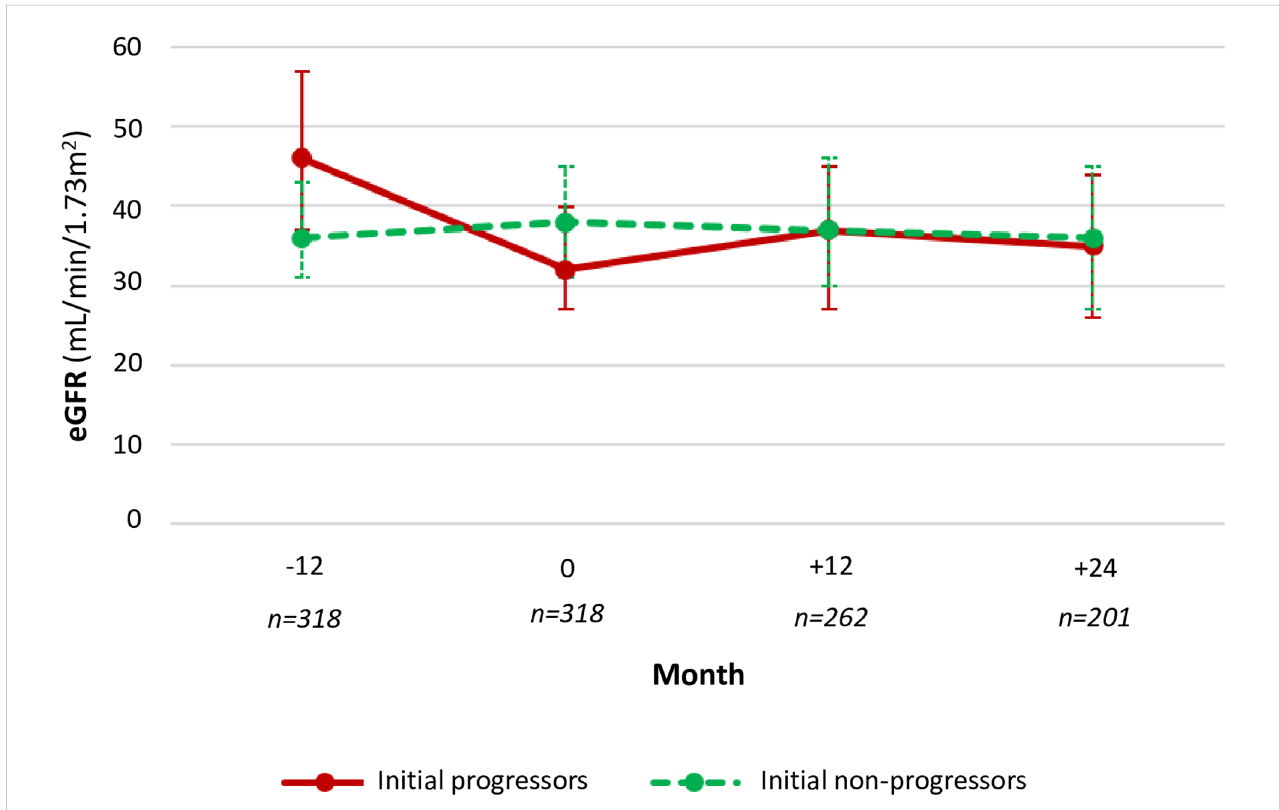
FIGURE 1 Evolution of the glomerular fi ltration rate according to initial progression.